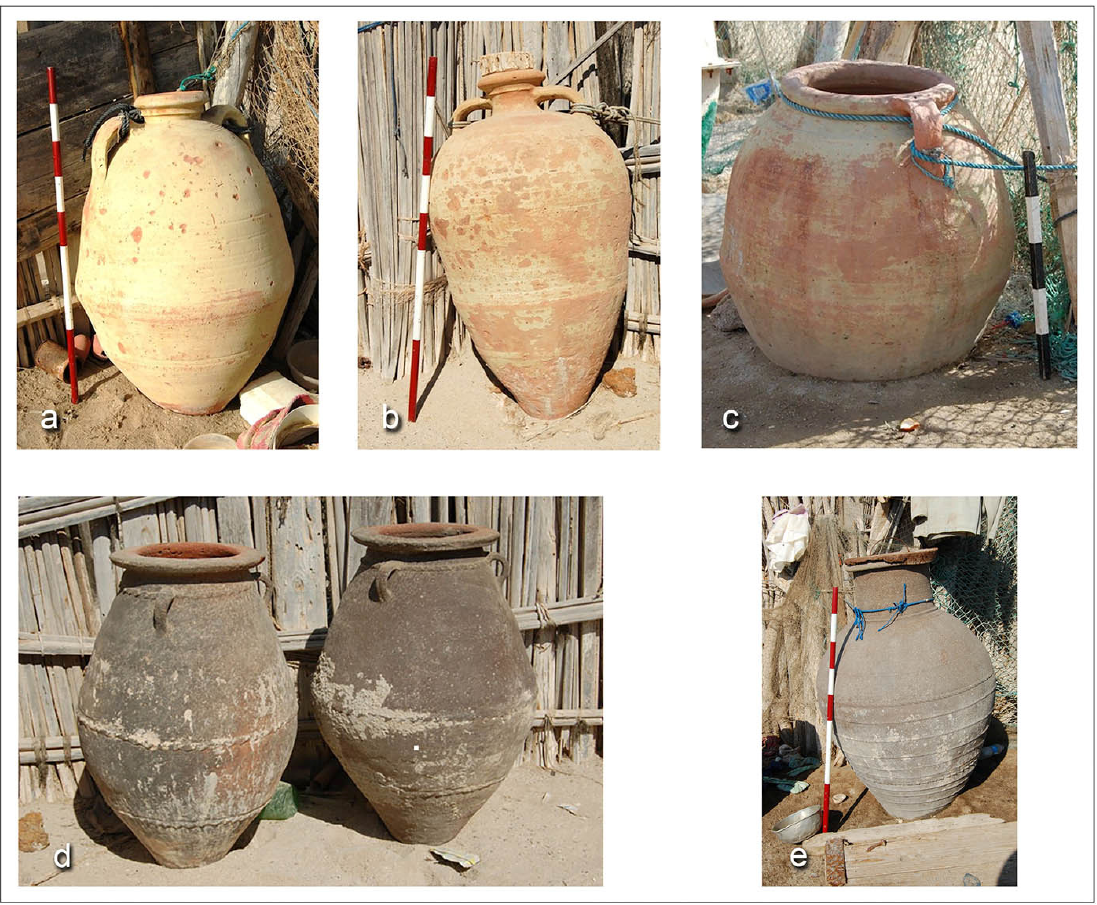
Figure 2. Types of amphorae and storage jars from Muhut island: ( a ) sefri type, ( b ) nosfi type, ( c ) jriba type, ( d ) Julfar ware, ( e ) grey gritty ware.